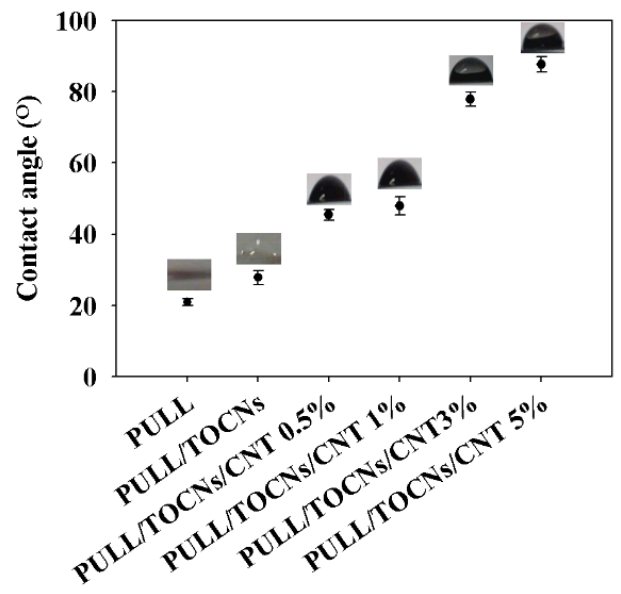
Figure 9. The water contact angle of the PULL/TOCNs/CNT nanocomposite films.